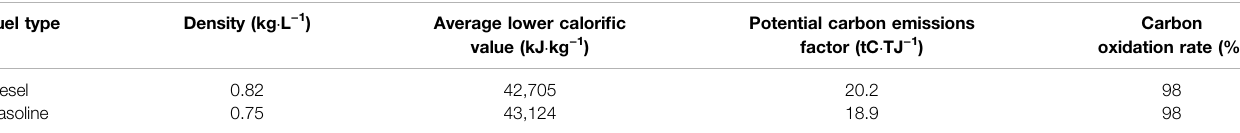
TABLE 2 | Variables for the CO 2 emissions factor